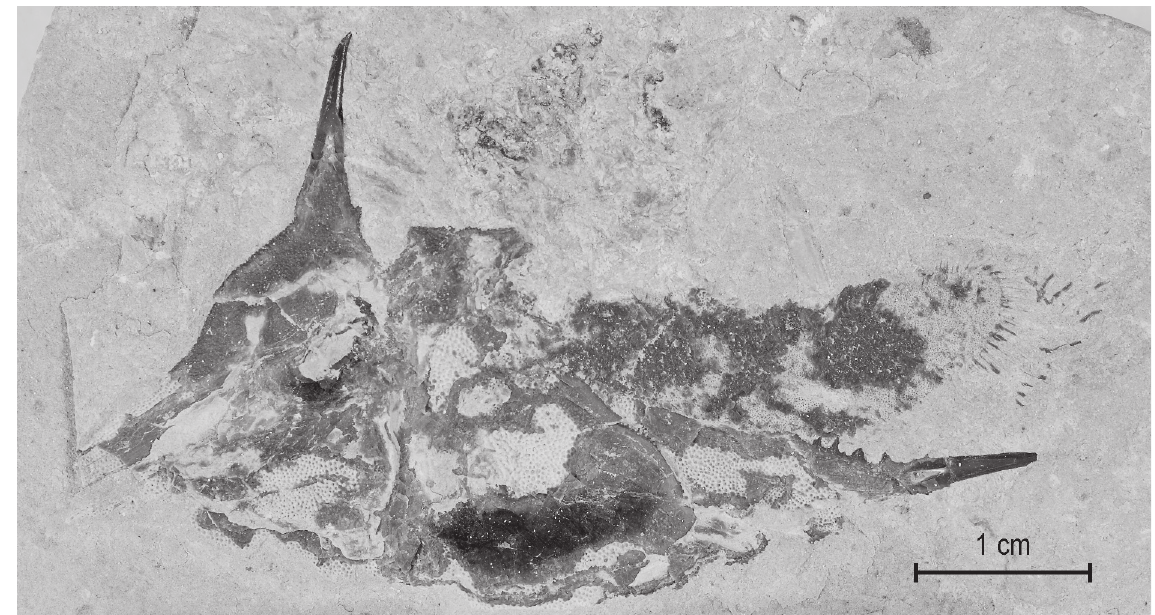
Fig. 17. Rostropycnodus gayeti gen. et sp. nov. Paratype CLC